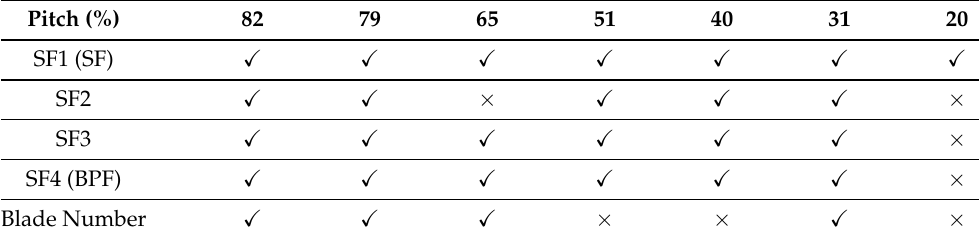
Table 5. The efficacy and robustness of the estimation of propeller